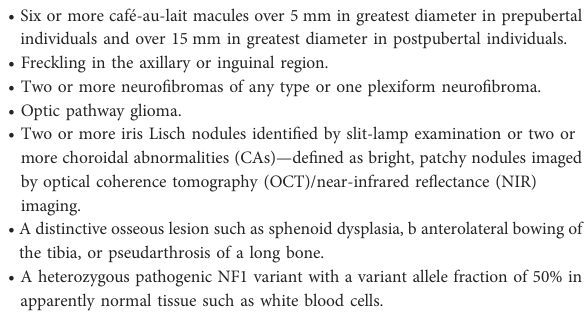
TABLE 1 Revised diagnostic criteria for neuro fi bromatosis type 1